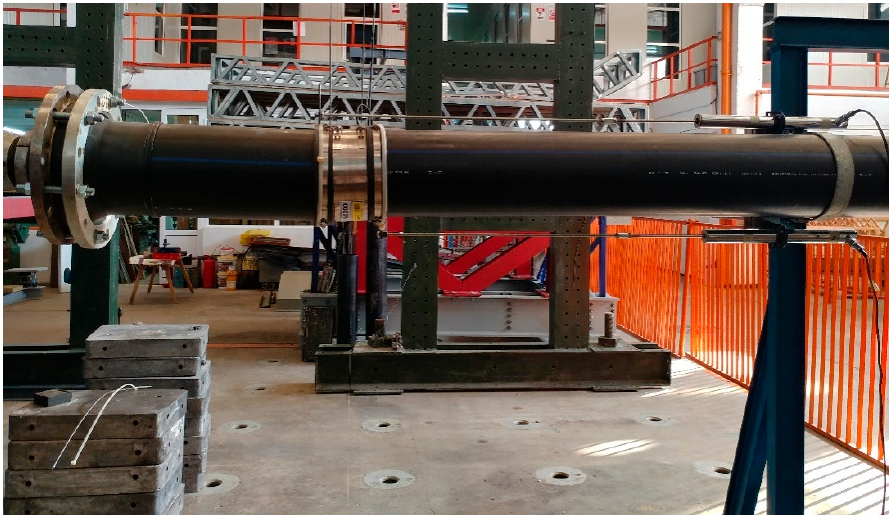
Figure 3. System consisting of two pipeline sections joined by a Flexseal SC200.